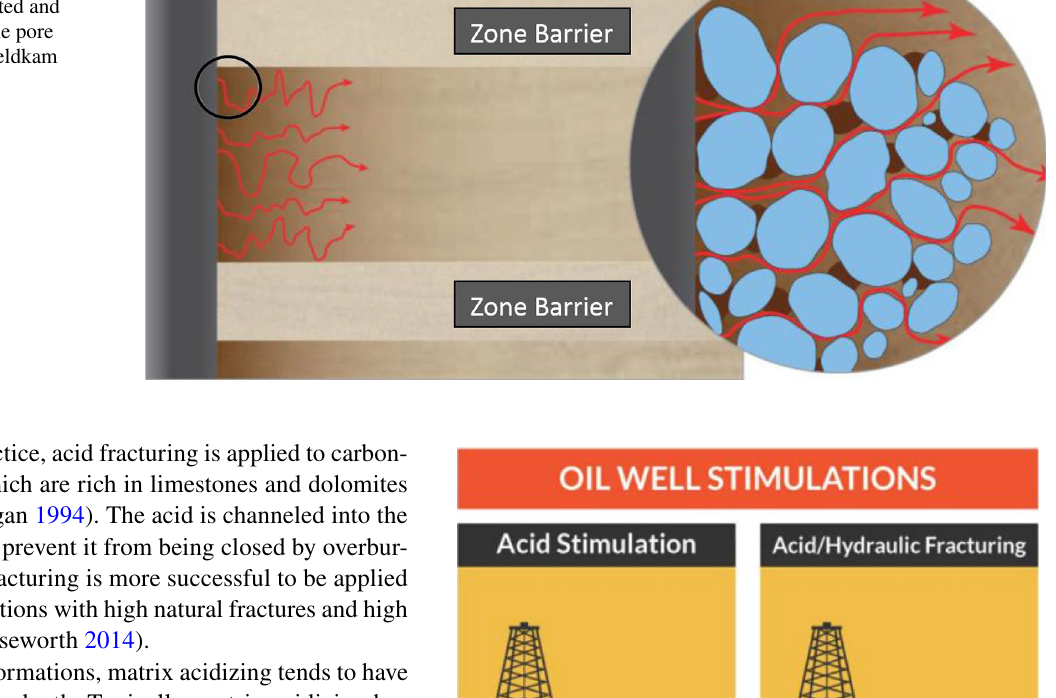
Fig. 1 Pore-scale figure of matrix acidizing process when the acid is being injected and acid passes through the pore space illustrated by Veldkam and Boxem (2015)